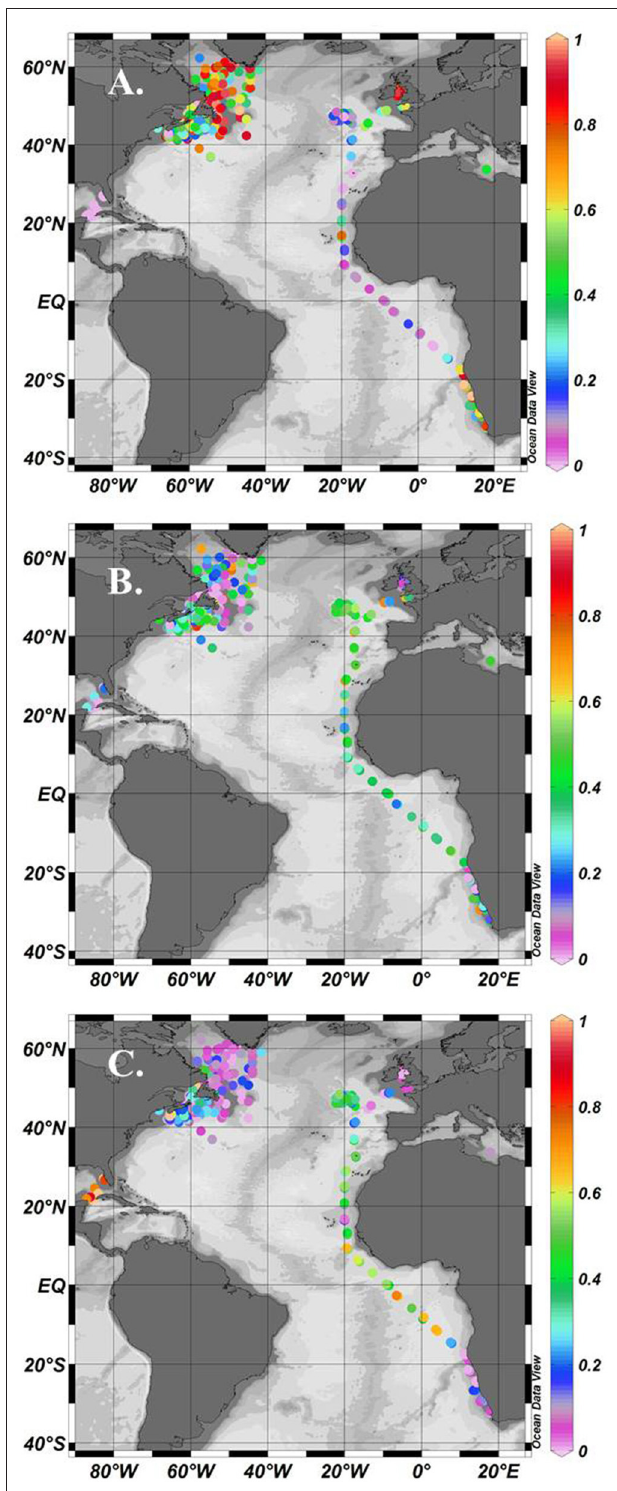
FIGURE 1 | Location of stations where simultaneous measurements of phytoplankton pigments and photosynthesis-irradiance curves were made showing stations dominated by micro- (A) , nano- (B), and pico-phytoplankton (C) using the method of Uitz et al. (2008). Colour scale is the relative fraction of each size class normalised to